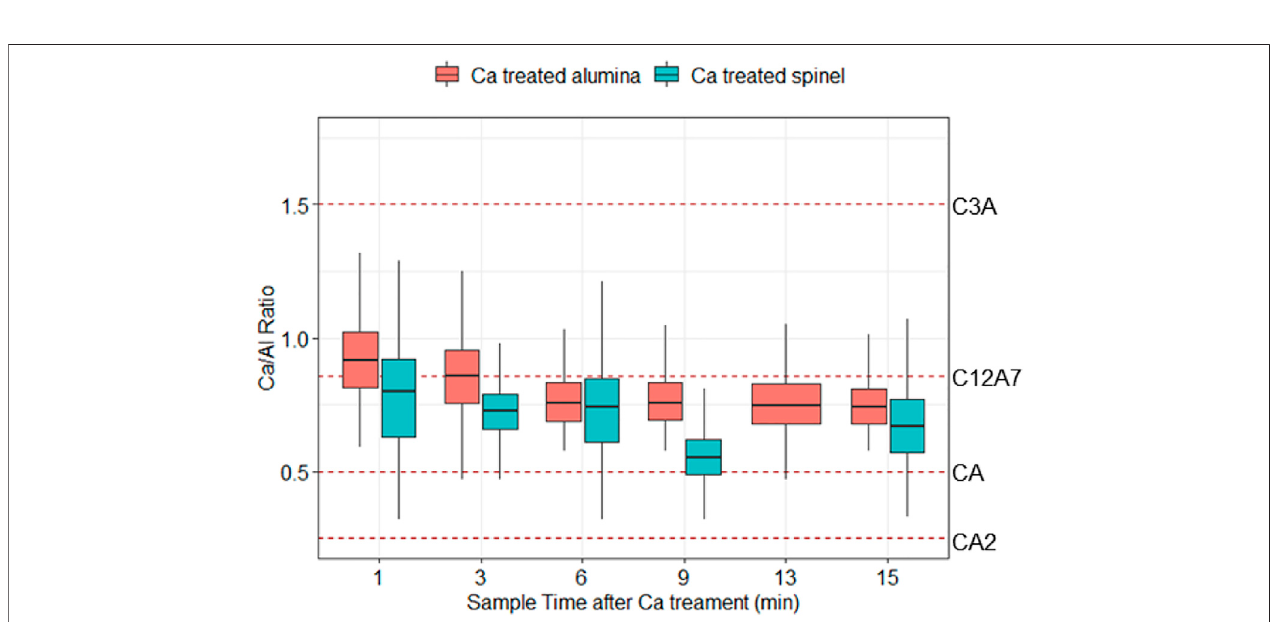
FIGURE 4 | Molar ratios of calcium to aluminum in inclusions after calcium treatment for experiments A ( “ Ca treated alumina ” ) and B ( “ Ca treated spinel ” ). The dashed lines indicate the stoichiometric ratios of CaO-Al 2 O 3 compounds found in the CaO-Al 2 O 3 phase diagram.